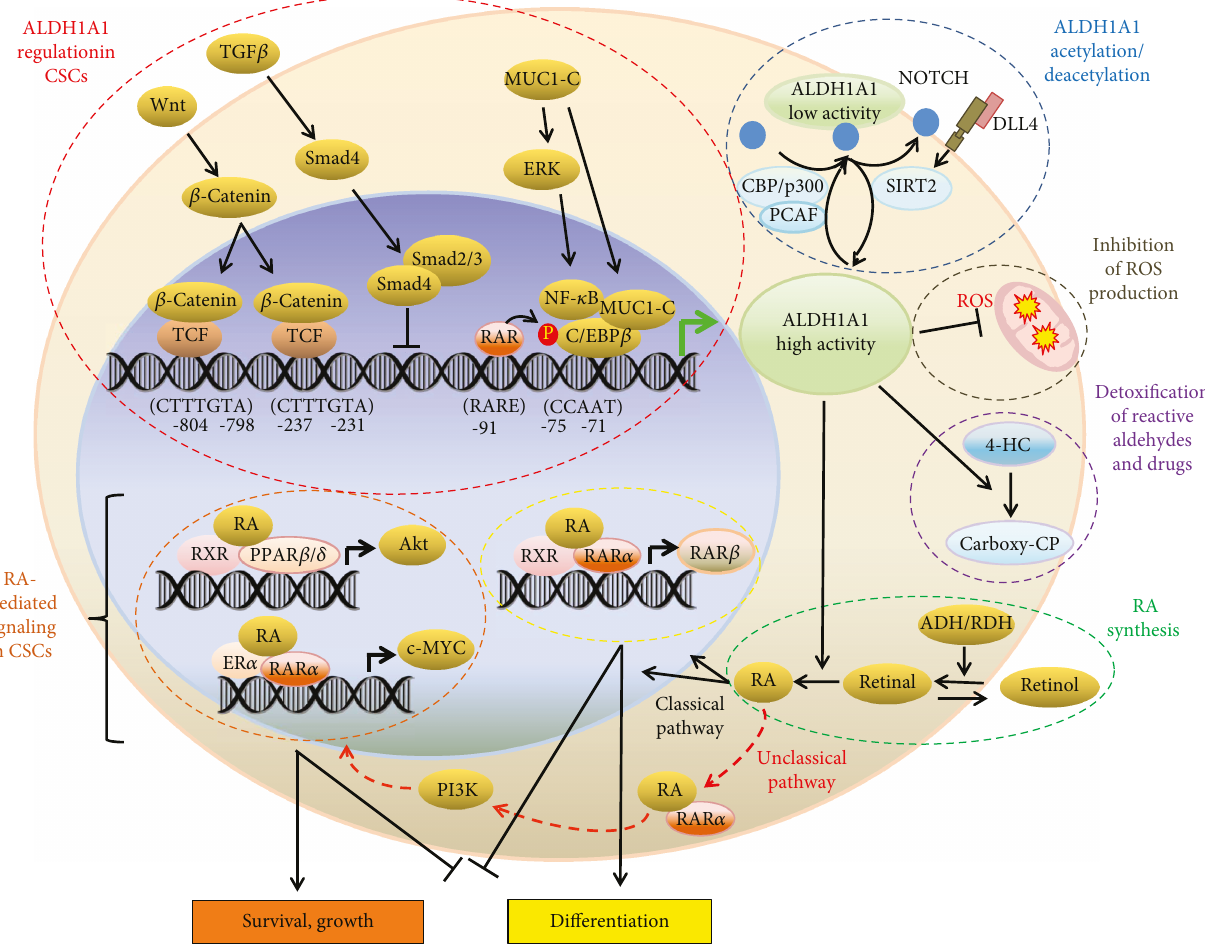
Figure 2: Model of ALDH1A1 regulation, potential retinoid signaling pathways, and functional e ff ects of ALDH in CSCs. Retinol is oxidized to retinal by retinol dehydrogenases, and retinal is then oxidized to RA by ALDH1 enzymes (green dotted line). In the classic pathway, RA enters the nucleus and binds to dimers of RAR α and RXRs triggering the expression of its downstream target genes including RAR β (yellow dotted line). In the nonclassic pathway, RA binds to dimers of RXRs and PPAR β / δ to induce the expression of its downstream target genes including Akt (orange dotted line). In cells expressing ER α , RA can bind to dimers of RXRs and ER α (not shown). RA can also bind with RAR α outside the nucleus to activate the PI3K/Akt pathway. Wnt pathway regulates ALDH1A1 through β -catenin/TCF-dependent transcription. MUC1-C induces ERK signaling and phosphorylates C/EBP β . The complex of MUC1-C and C/EBP β occupies the sequence upstream from the transcription initiation site of ALDH1, triggering ALDH1A1 expression. TGF- β -induced Smad4 downregulates ALDH1 (red dotted line). Notch promotes ALDH activity in CSCs through induction of deacetylase SIRT2, leading to ALDH1A1 deacetylation, while ALDH1A1 acetylation by acetyltransferase PCAF inhibits ALDH activity (blue dotted line; some parts of this fi gure were adapted with modi fi cations from Figures 1 and 2 from Xu et al. [20], with editor ’ s